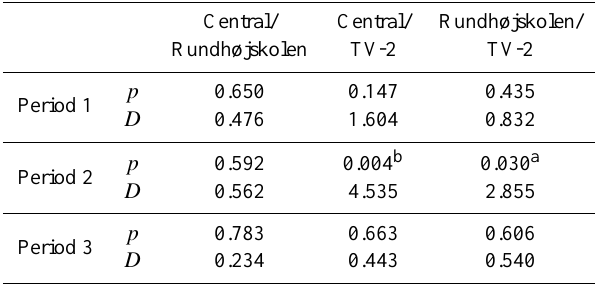
Table 1. Anderson–Darling test (with adjustment for ties) for differ- ences in peak-time distribution between the three monitoring sta- tions for each seasonal period. D is the Anderson–Darling rank statistic and p the associated